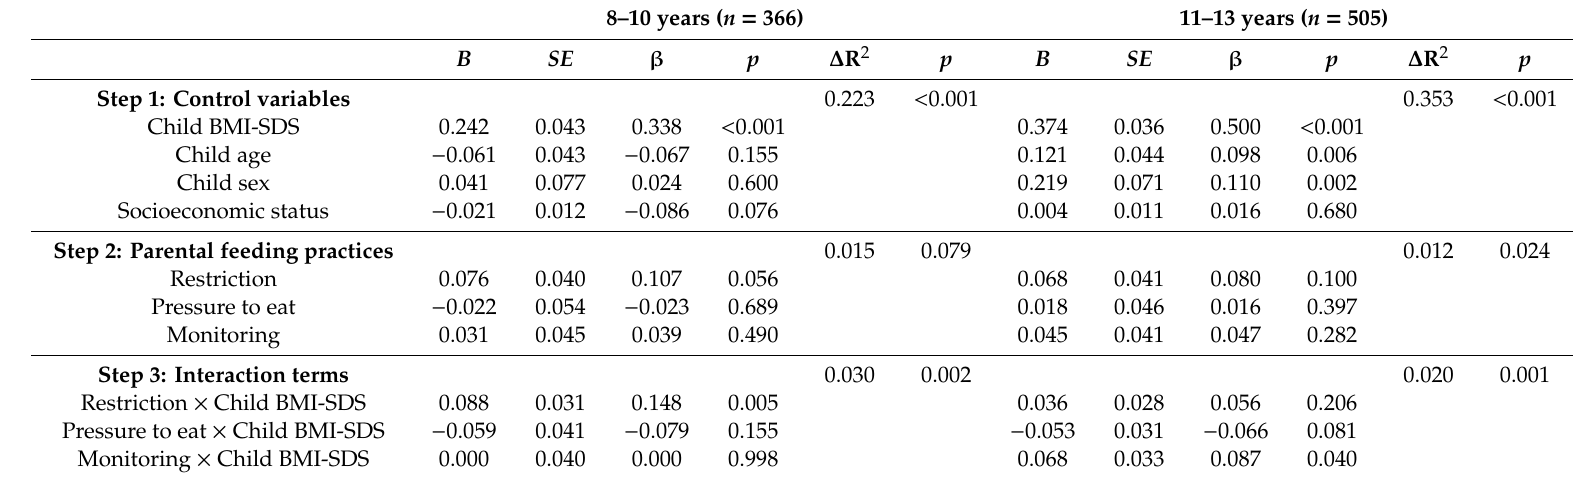
Table 2. Summary of hierarchical linear regression analyses (full model) for the prediction of global eating disorder psychopathology (ChEDE-Q Global Score) in younger (8–10 years) and older (11–13 years)